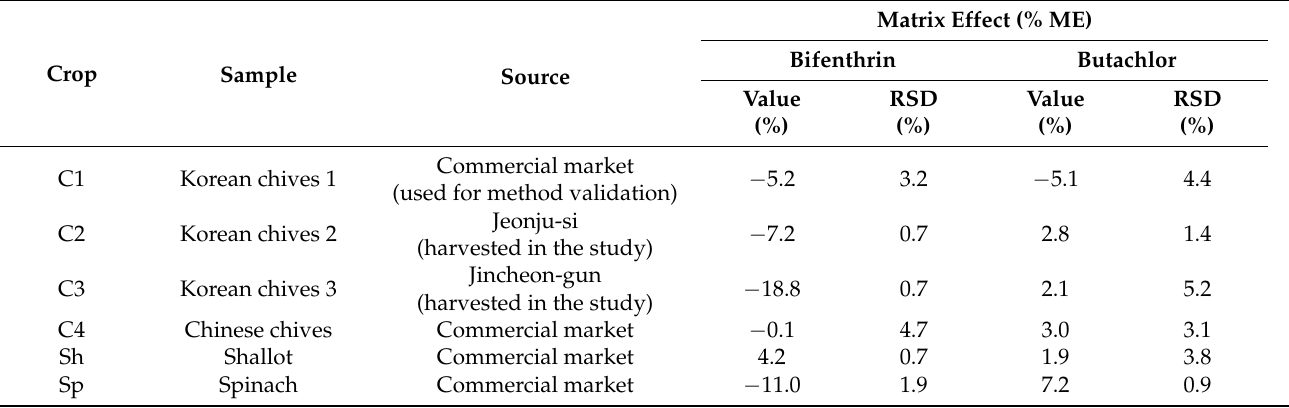
Table 5. Evaluation of the matrix effects of bifenthrin and butachlor in chives from various sources and leafy vegetables ( n =